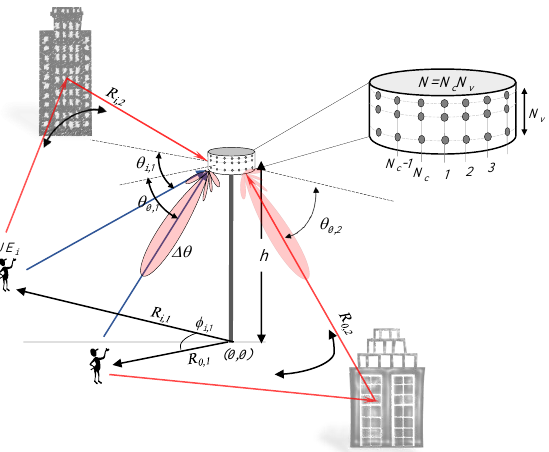
Figure 1. Configuration of a N c × N v uniform cylindrical array (UcylA) with line-of-sight (LOS) and non-line-of-sight (NLOS) links: ( φ i , (cid:96) , θ i , (cid:96) ) are the azimuth and elevation angels; h is the height of the array; and the pointing directions are toward all the LOS ( (cid:96) = 1) and NLOS ( (cid:96) = 2,3, · · · ) links arriving from the user equipment (UE) over a propagation path R i , (cid:96)